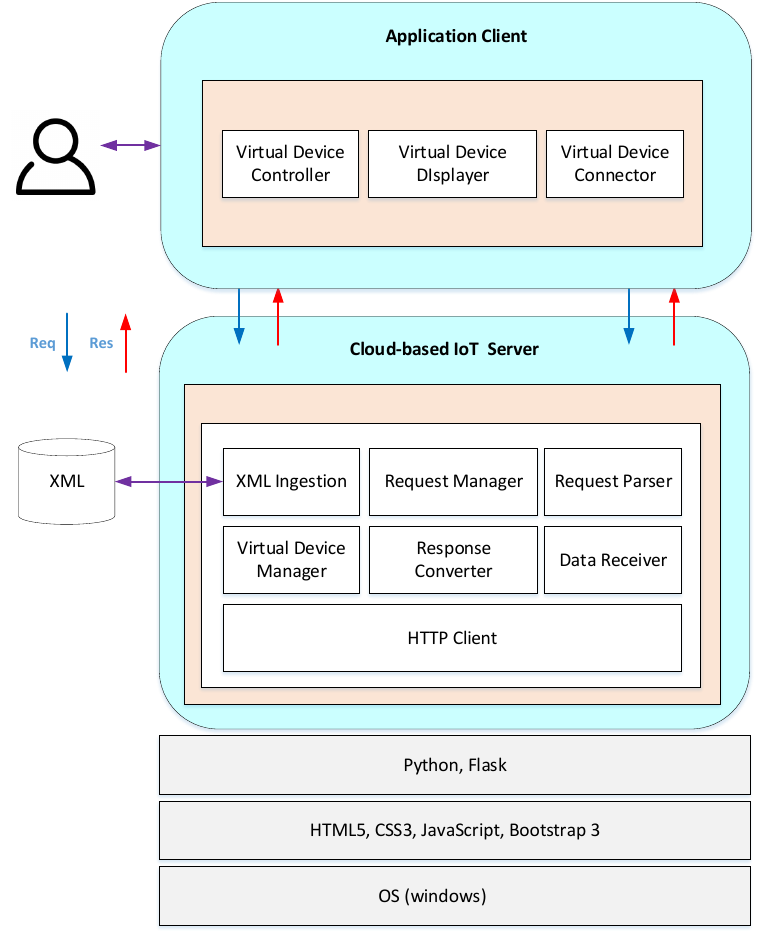
Figure 4. Cloud-centric application